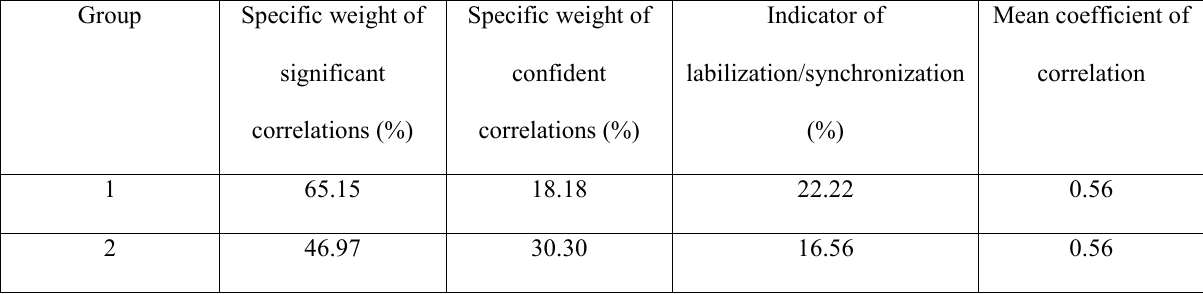
Indicators of correlation matrixes of arm wrestlers’ psychological